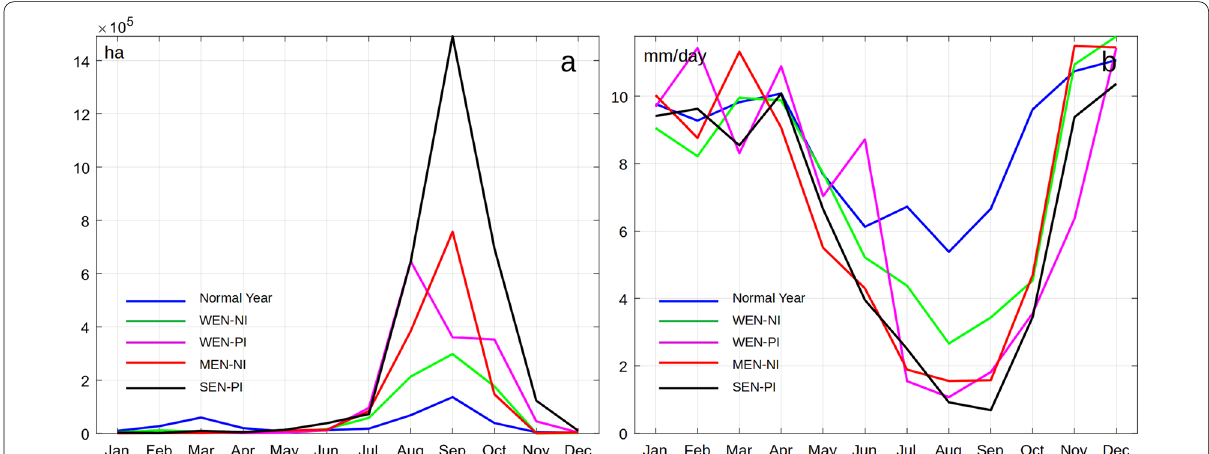
Fig. 5 Temporal of joint pattern for each category on Kalimantan. Burned area graph ( a ) represents the average total burned area of the composite year. In contrast, the precipitation graph ( b ) represents the average monthly average precipitation from each grid of the composite year for each